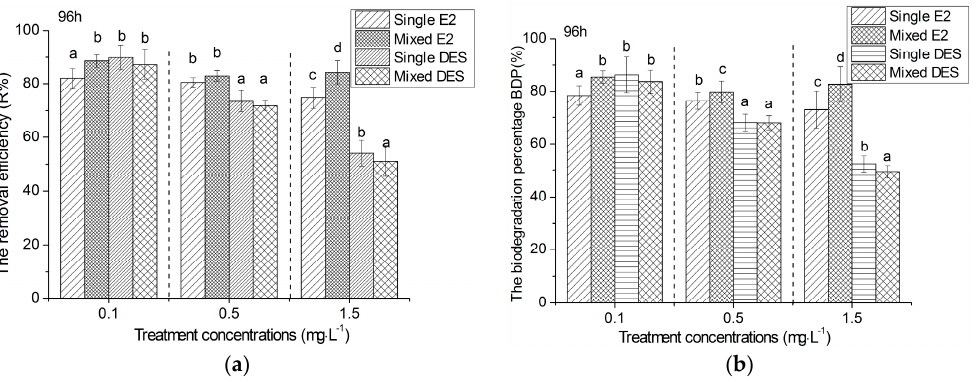
Figure 3. Removal ef fi ciency ( a ) and biodegradation ( b ) of estrogens by R. subcapitata in different concentrations after 96 h. Mean and standard deviation of the three replicates are shown. The mean with lowercase a–c in each concentration indicates that they were signi fi cantly different at p ≤ 0.05 according to one ‐ way ANOVA test (Duncan).